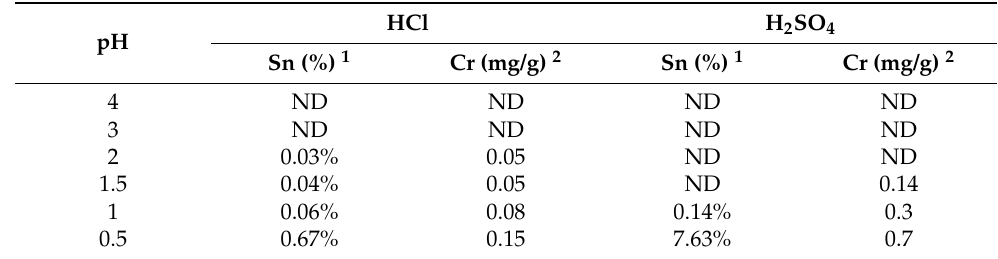
Table 2. Dissolved Sn and Cr in relation to dissolution pH for different acids (C ads : 10 g/L, T: 25 ◦ C, t = 30 min).